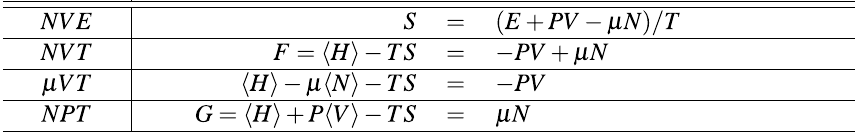
Table 1. Thermodynamic